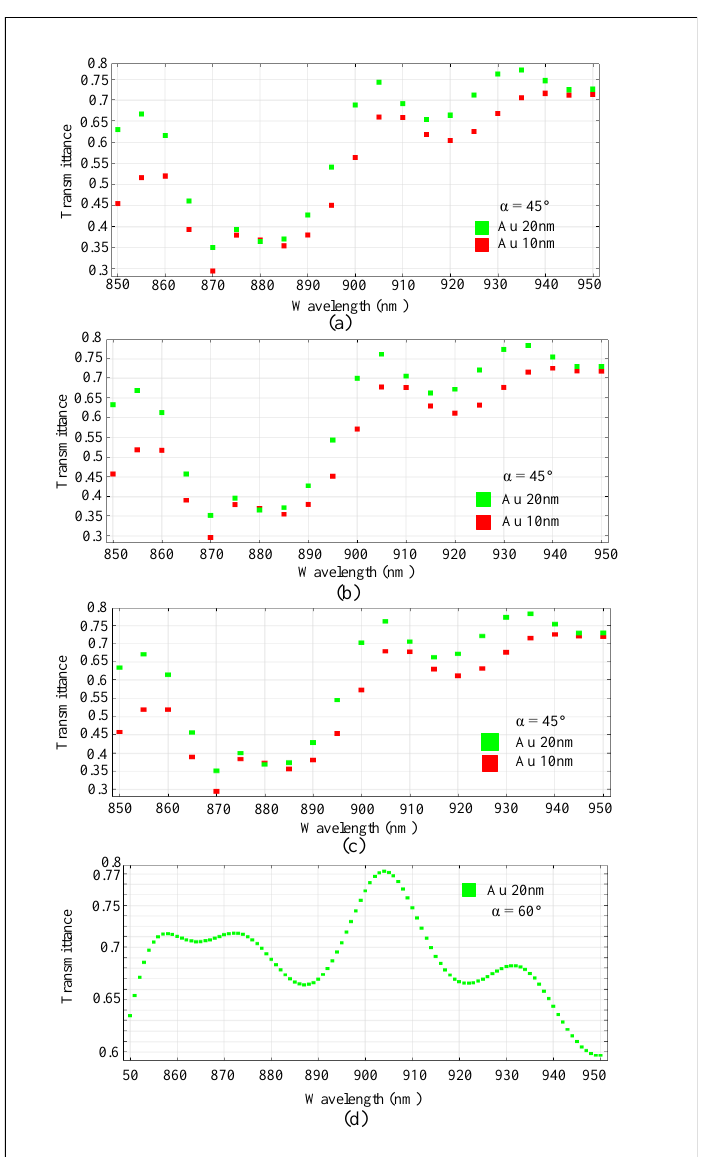
Figure 9. ( a , b ) The transmittance diagram for the PhC structure consisting of large nanorods of GaP and GaN and small nanorods of Au with a deflection angle of 45°. ( c ) The transmittance diagram for PhC structure consisting of large LiNbO3 nanorods and small Al nanorods with a deflection angle of 45°. ( d ) The transmittance diagram for the PhC structure consisting of large GaAs nanorods and small Al nanorods with a deflection angle of